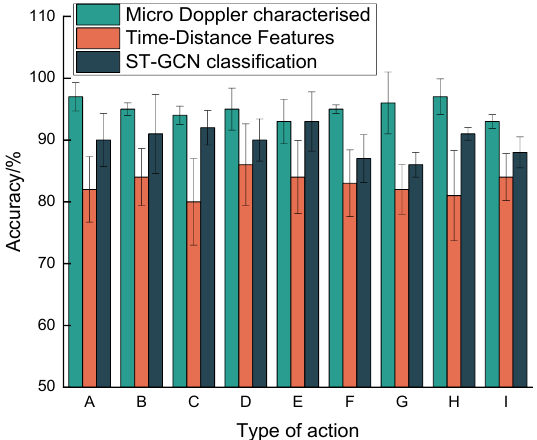
Figure 14. Histogram for analysis of experimental results.